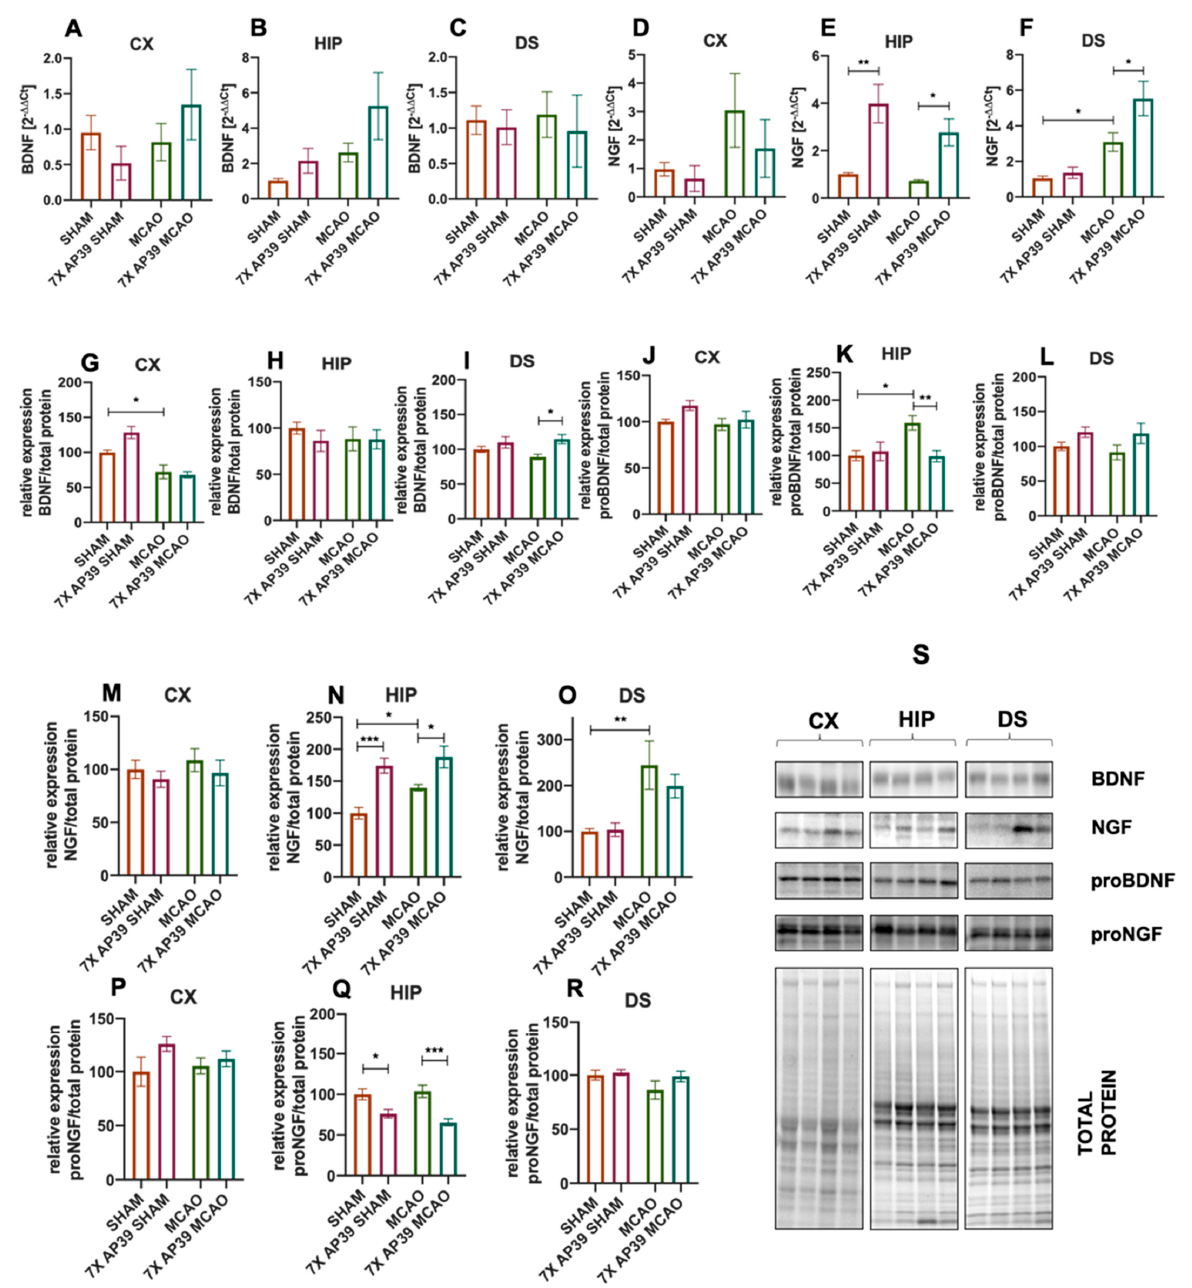
Figure 7. The effect of MCAO and the treatment with AP39 on the mRNA and protein expression levels of the neurotrophic factors. ( A – C ) Relative mRNA expression level of BDNF in the frontal cortex (CX), hippocampus (HIP) and in the dorsal striatum (DS), respectively. ( D – F ) Relative mRNA expression level of NGF in the CX, HIP and in the DS, respectively. ( G – I ) The protein expression level of BDNF in the CX, HIP and in the DS, respectively. ( J – K ) The protein expression level of proBDNF in the CX, HIP and in the DS, respectively. ( M – O ) The protein expression level of NGF in the CX, HIP and in the DS, respectively. ( P – R ) The protein expression level of proNGF in the CX, HIP and in the DS, respectively. ( S ) Immunoblots representative for the CX, HIP and DS for BDNF, NGF, proBDNF and proNGF, together with the total protein amount visualized by the stain-free technique. The order of the samples is the same as in the graphs. n = 6, one-way ANOVA, followed by Sidak’s correction for post hoc comparisons; * p < 0.05, ** p < 0.01 and *** p < 0.001 vs. MCAO or SHAM. Data are presented as the mean ± SEM.